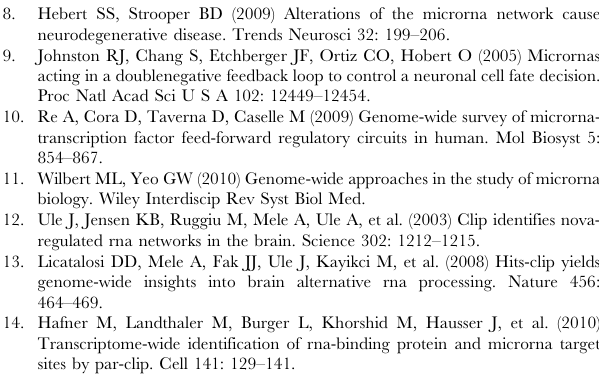
Table S1 SNPs predicted to affect 3 9 -UTR splicing. The first column lists the SNP rs-numbers, in the second column the respective transcripts are given and the third column contains the genomic locus of the SNP including strand information of the transcripts. The fourth column shows the conservation of the SNP in binary code, i.e. 1 means conserved, 0 means not conserved. The fifth column gives the type of the gained splice site, the score column contains the likelihood of NNSplice and the last column provides the percentage of lost RBP binding sites for the accordant transcripts. Table S2 SNPs predicted to affect 3 9 -UTR secondary structure. The first column lists the SNP rs-numbers, in the second column the respective transcripts are given and the third column contains the genomic locus of the SNP including strand information of the transcripts. The fourth column shows the conservation of the SNP in binary code, i.e. 1 means conserved, 0 means not conserved. The fifth column lists the correlation coefficient of the wild-type structure to the mutated structure of the respective transcripts. Table S3 SNPs disrupting existing MREs. The first column lists the SNP rs-numbers, in the second column the respective transcripts are given and the third column contains the genomic locus of the SNP including strand information of the transcripts. The fourth column shows the conservation of the SNP in binary code, i.e. 1 means conserved, 0 means not conserved. The fifth column lists the miRNAs the MREs of which are affected. Table S4 SNPs creating new MREs. The first column lists the SNP rs-numbers, in the second column the respective transcripts are given and the third column contains the genomic locus of the SNP including strand information of the transcripts. The fourth column shows the conservation of the SNP in binary code, i.e. 1 means conserved, 0 means not conserved. The fifth column lists the miRNAs for which MREs are